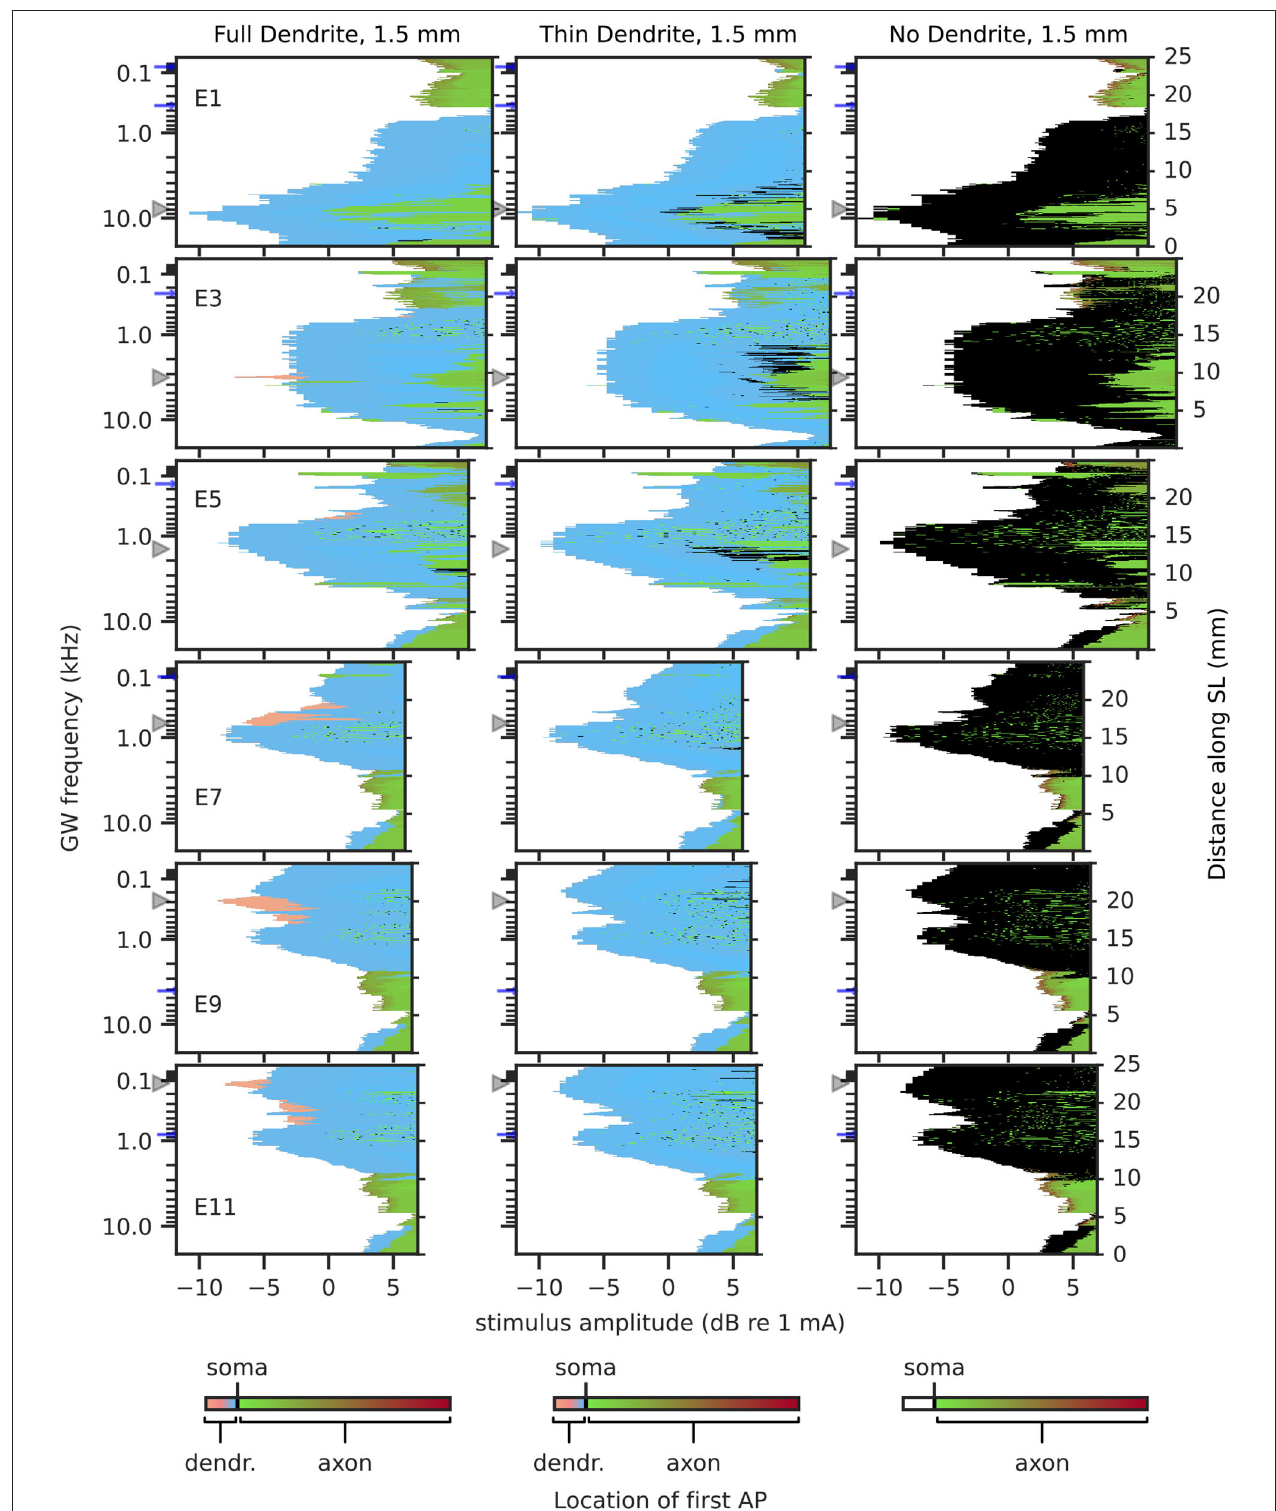
FIGURE 8 | Excitation profiles for 1.5mm dendrites. Greenwood frequency mapping performed for all 400 fibers, marked on the left ordinate. Fiber position along spiral lamina marked on the right ordinate. AP initiation site is color-coded, soma marked with black color. Stimulation electrodes labeled on the right. Electrode position is mapped to its nearest fiber and indicated by gray triangles, blue arrows mark fibers at ± 360 ◦ to the stimulation electrodes.